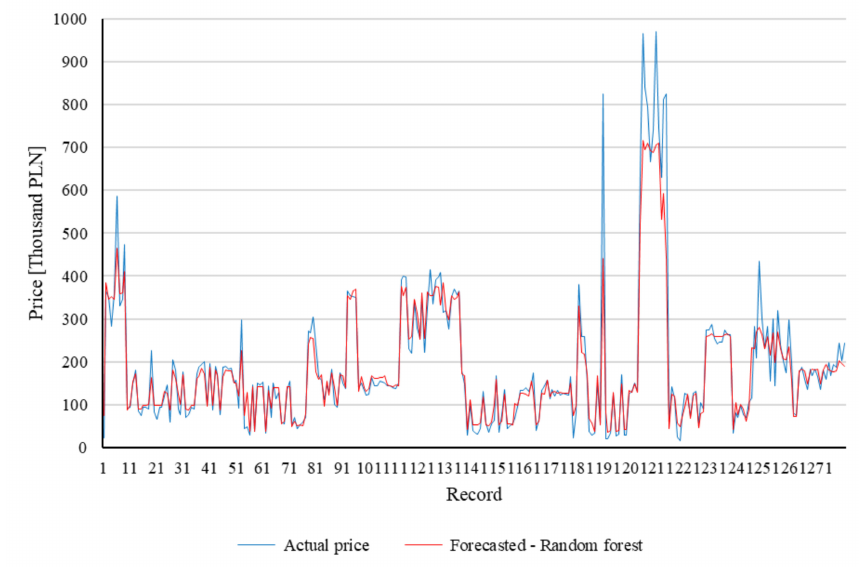
Figure 7. Results of forecasting the price of electric cars using random forest